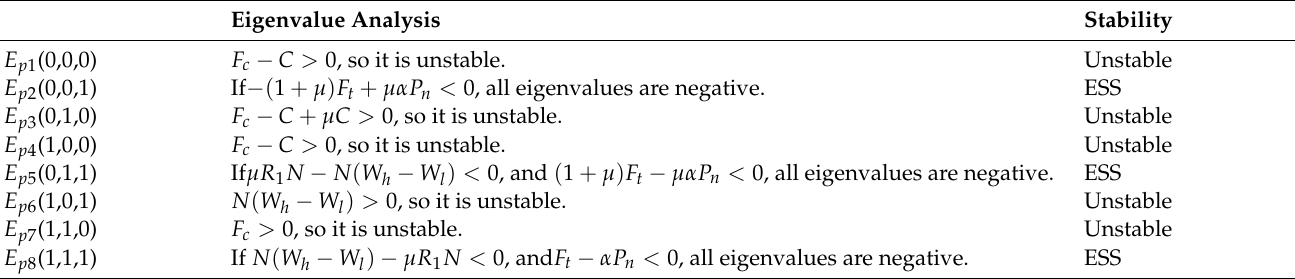
Table 4. Stability analysis of equilibrium